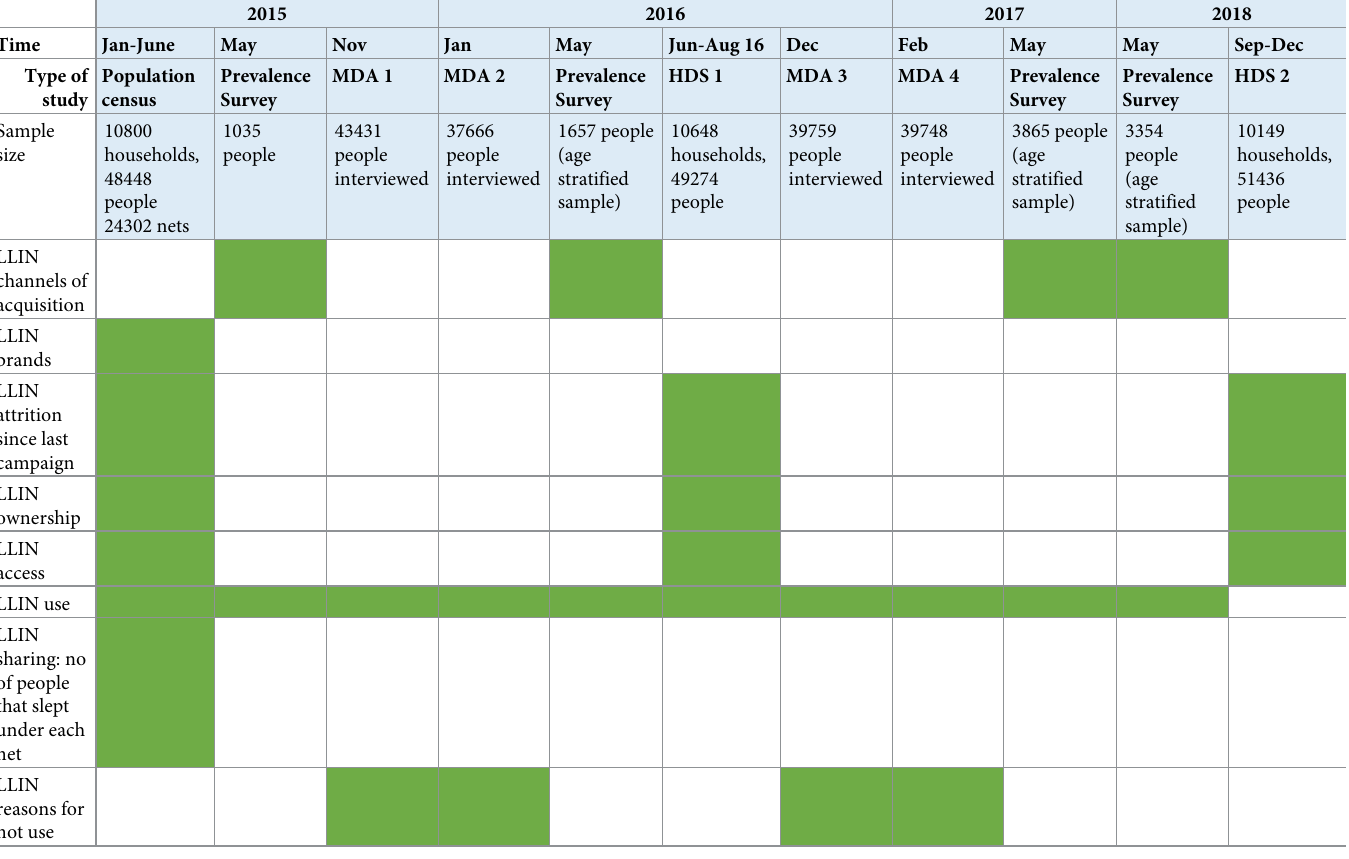
Table 1. Data sources, their sample sizes and LLIN indicators estimates derived from each